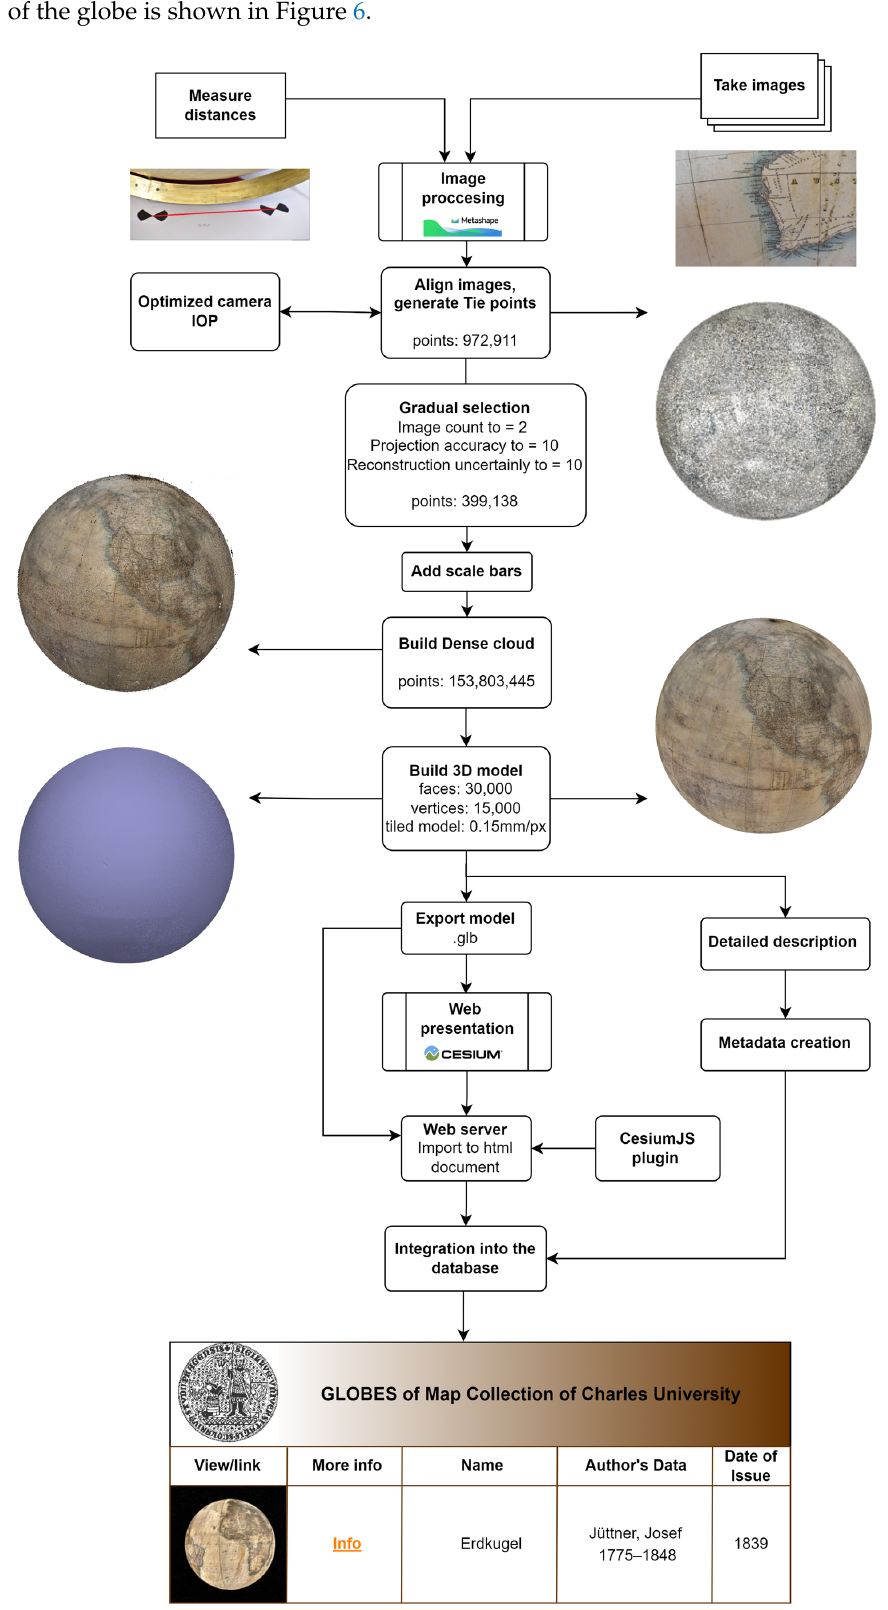
Figure 6. The processing steps of digitization, visualization and accessibility of the globe. Source: author.